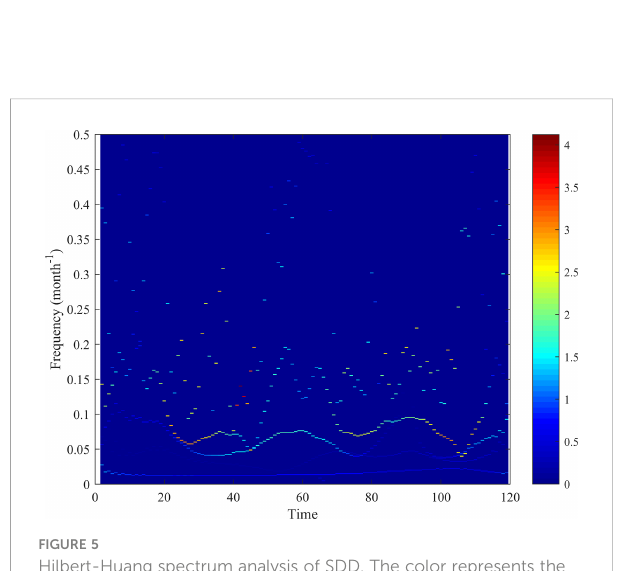
FIGURE 5 Hilbert-Huang spectrum analysis of SDD. The color represents the energy value, where the higher the value, the higher the energy event.